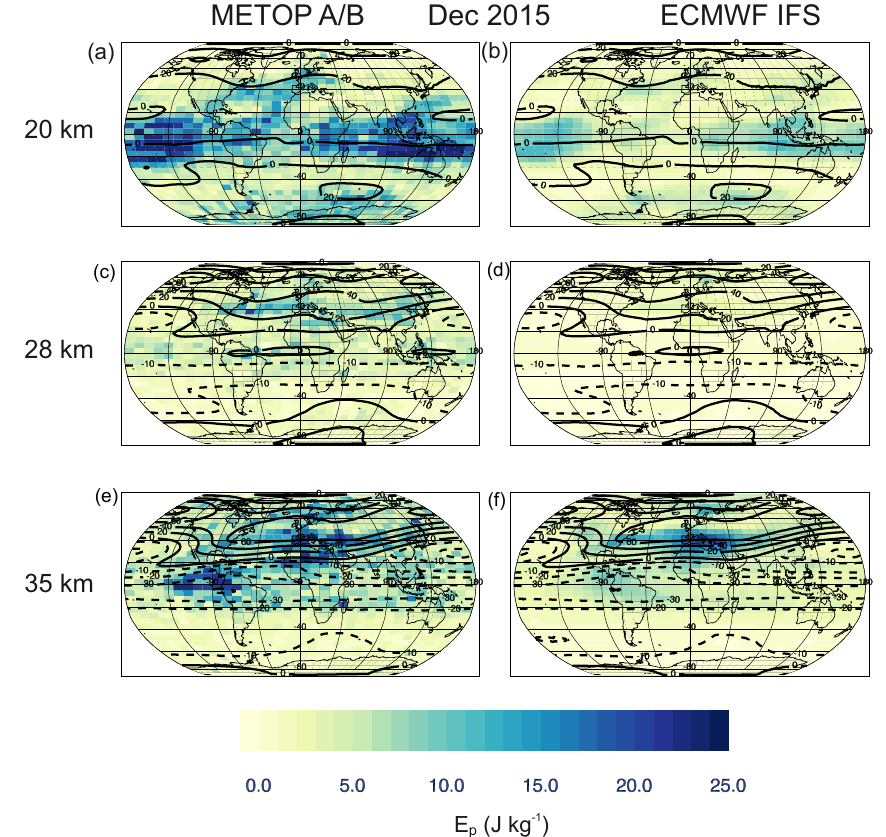
Figure 11. (a, c, e) Latitude–longitude distributions of E P based on GPS RO-dry data for December 2015 and altitudes of 20, 28, and 38km (a–fs) . (b, d, f) Same as panels (a, c, e) but based on IFS data. In all panels black contours show zonal wind values from